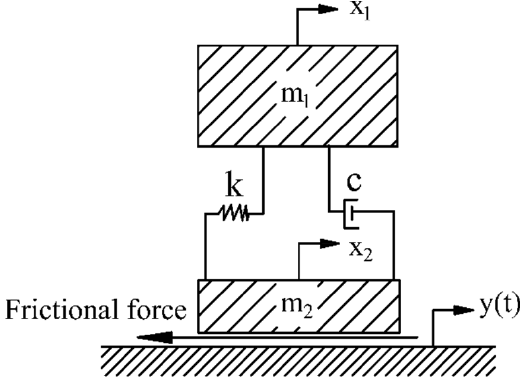
Figure 10. Mathematical model of a two-DOF sliding system.